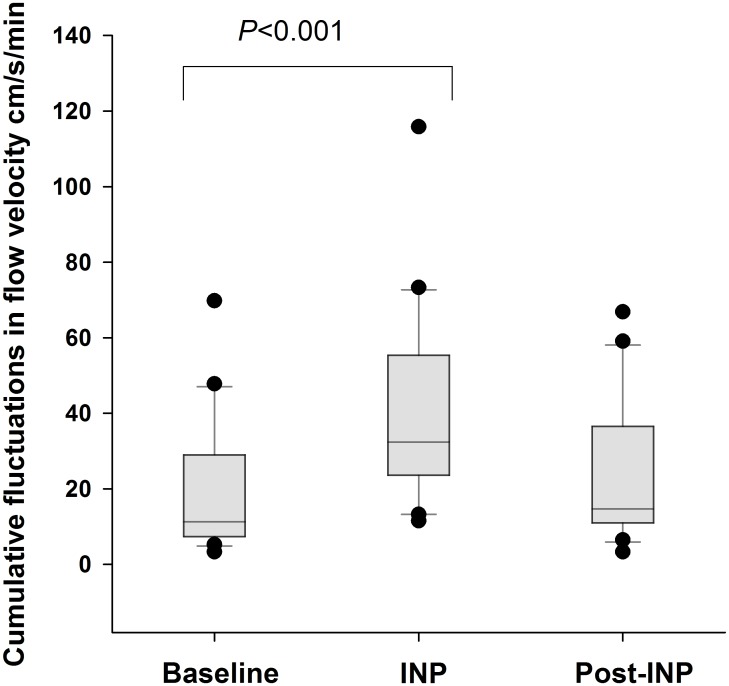
Fluctuations (cumulative up-and-down) in blood flow velocity during baseline (no pressure), INP, and post-INP (no pressure) sequences.The cumulative up-and-down are calculated per minute. Whiskers are 10th and 90th percentiles.